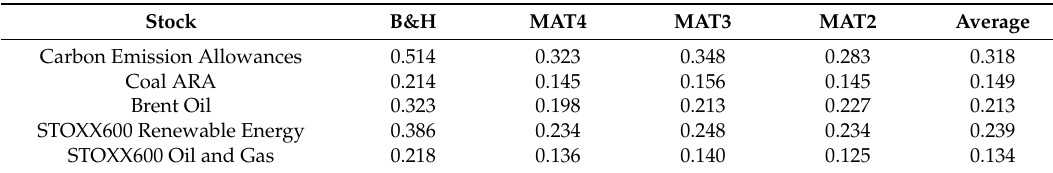
Table A12. Annualized daily (every third month) volatility of MAT2–MAT4 (T = every third month, and 4, 3, 2, are the numbers of observations in the rolling window), average annualized volatility.